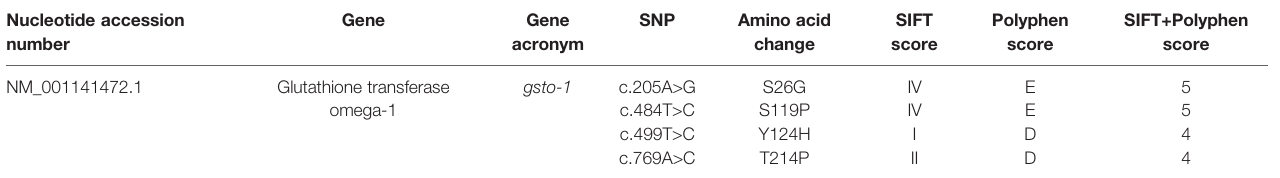
TABLE 4 | Effect of nonsynonymous single-nucleotide polymorphisms (SNPs) in glutathione transferase omega-1 coding region of Salmo salar . Nucleotide accession